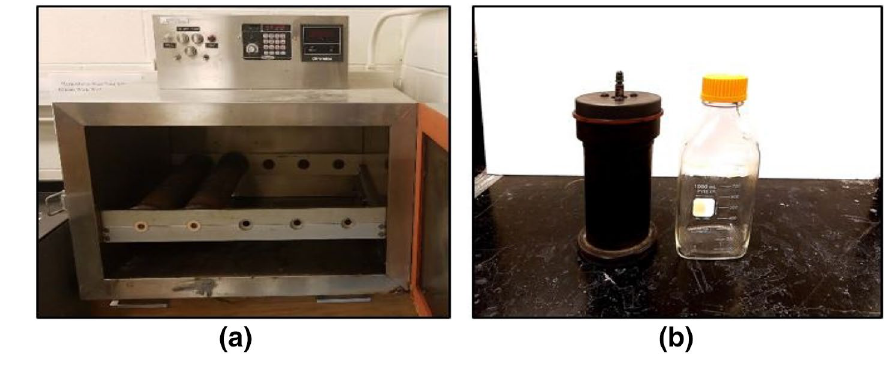
Table 2 The findings of introducing of BSSSP additives the reference fluid